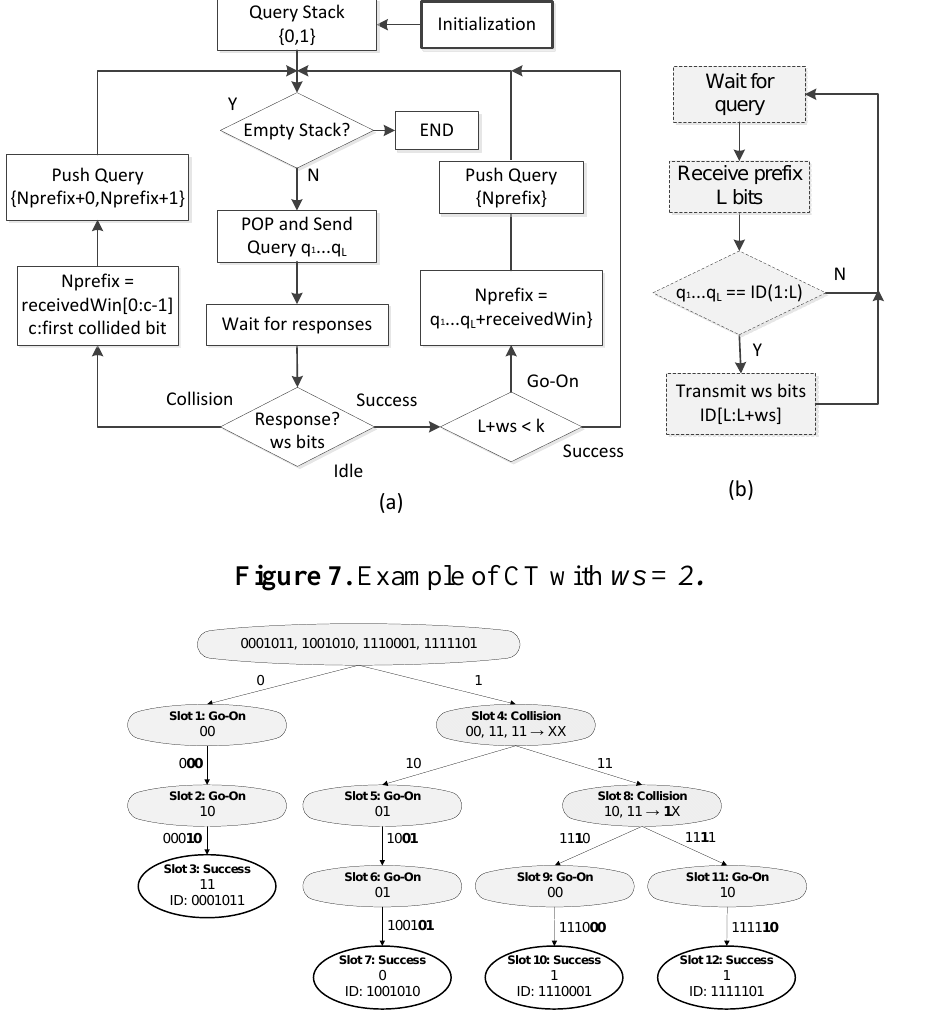
Figure 6. Flowchart of CT with window: ( a ) for reader, ( b ) for tags.